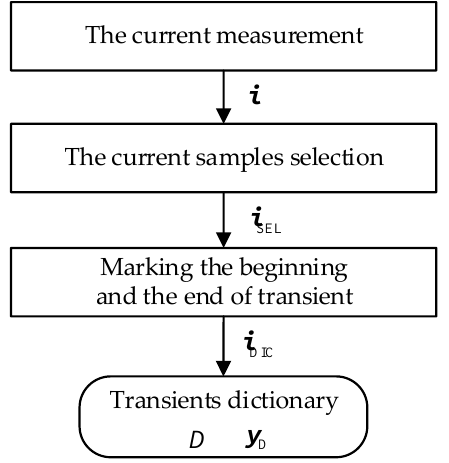
Figure 7. Preparation of dictionary of transients.